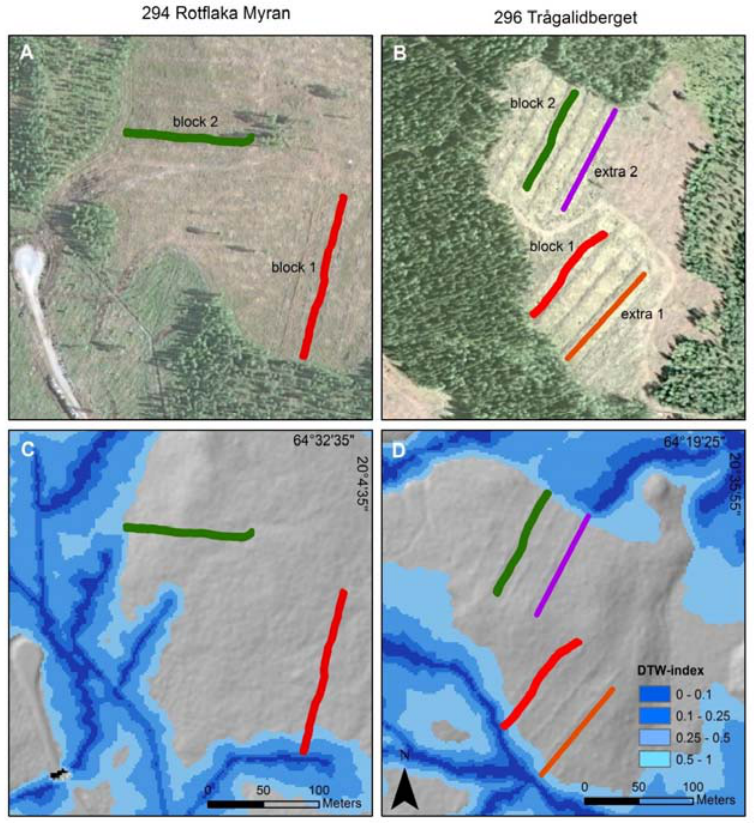
Figure 6. Field experiment in northern Sweden, using study plots in a randomized block design, to study forwarder traffic on harvested slopes. ( A , B ) show the aerial photos of the study sites and the location of the wheel tracks in the study plots subjected to the treatment forwarder traffic without soil protection (red lines for the wheel tracks in block 1, green lines for block 2, and purple and orange lines for two additional plots which were not part of the original study); ( C , D ) show the sunlit elevation model (in greyscale) with a high flow DTW-index map superimposed (1 ha stream initiation). The location of the green baseflow DTW model as seen in Figure 5 is not visible in these areas, but starts just outside the displayed